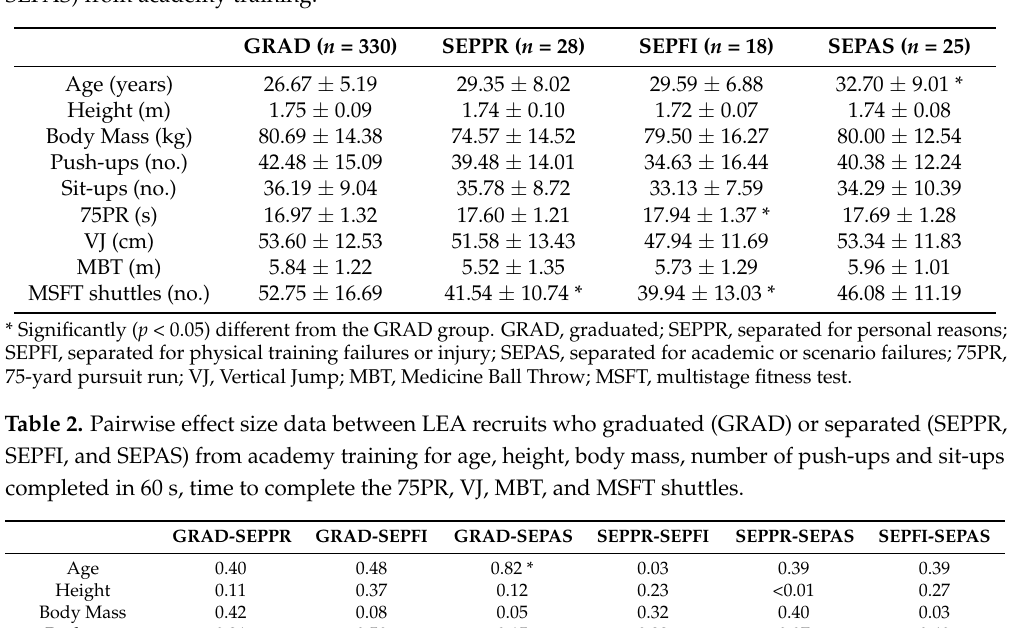
Table 1. Descriptive data (mean ± SD) for age, height, body mass, and fitness test performance data for law enforcement academy (LEA) recruits who graduated (GRAD) or separated (SEPPR, SEPFI, and SEPAS) from academy training.